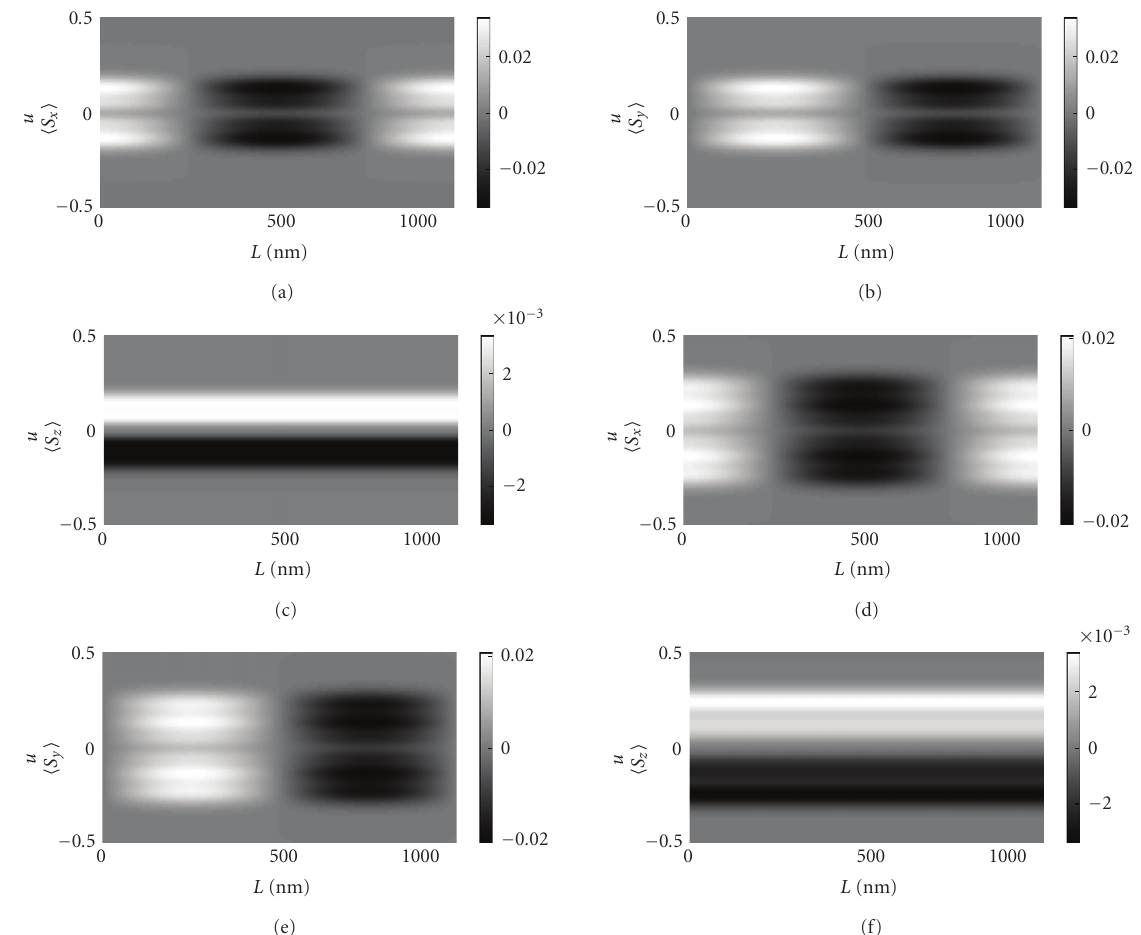
Figure 1: The 2D contour of spin polarization components (cid:2) S i (cid:3) ( i = x , y , z ) as functions of transverse position u and length L for n = 3 ((a), (b), (c)) and n = 5 ((d), (e), (f)) propagation modes QW with α R = 0 . 5 × 10 − 11 eVm.